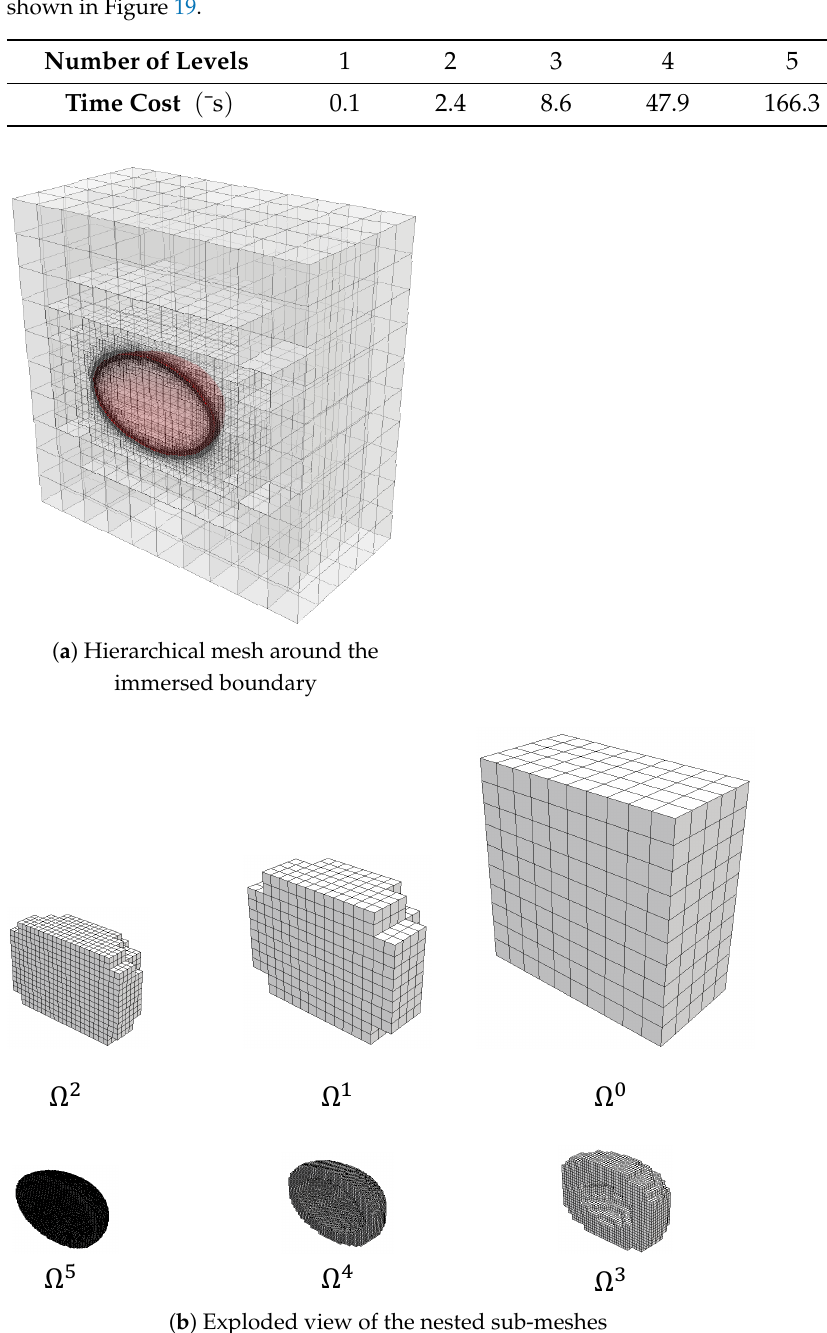
Figure 19. A three-dimensional six-level hierarchical refinement of a cubic domain with respect to an ellipsoidal boundary: ( a ) hierarchical mesh and ( b ) sub-meshes in each